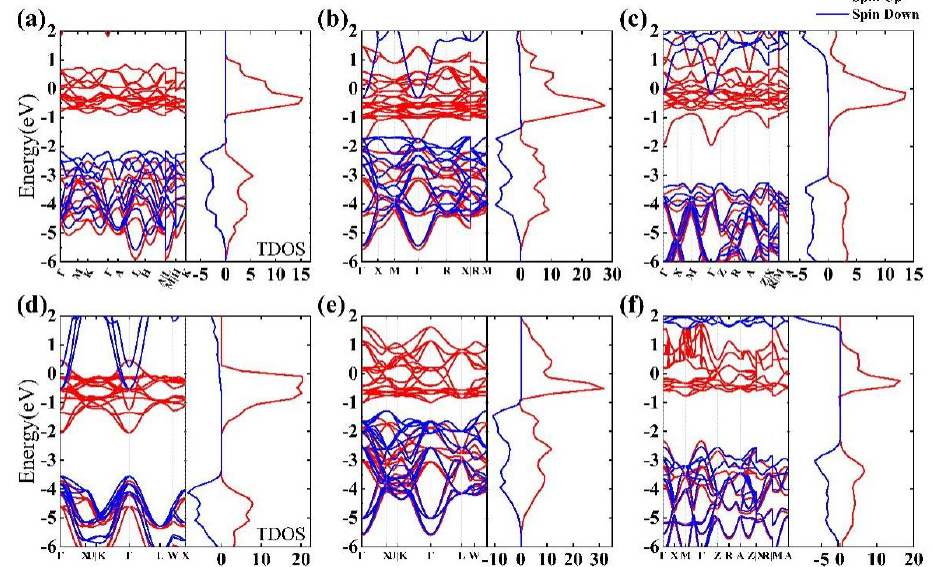
Figure 2. The upper left figure shows the electronic structure band, and the upper right figure shows the total electron density of states (TDOS) of ( a ) β -Pu 2 O 3 , ( b ) α -Pu 2 O 3 , ( c ) γ -Pu 2 O 3 , ( d ) PuO, ( e ) α -PuO 2 , ( f ) γ -PuO 2 . The red line is represented by electrons that spin downwards and the blue line is represented by electrons that spin upwards. The location with an energy of 0 represents the Fermi level.